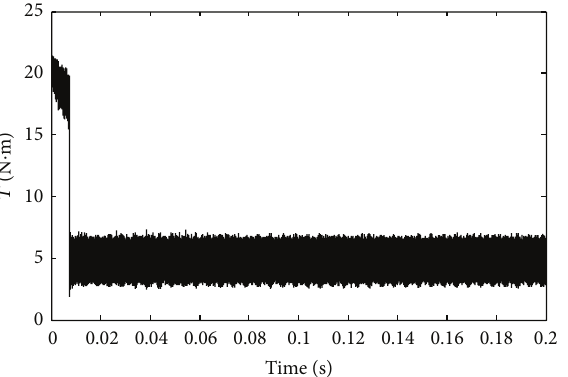
Figure 9: The simulation waveform of torque.